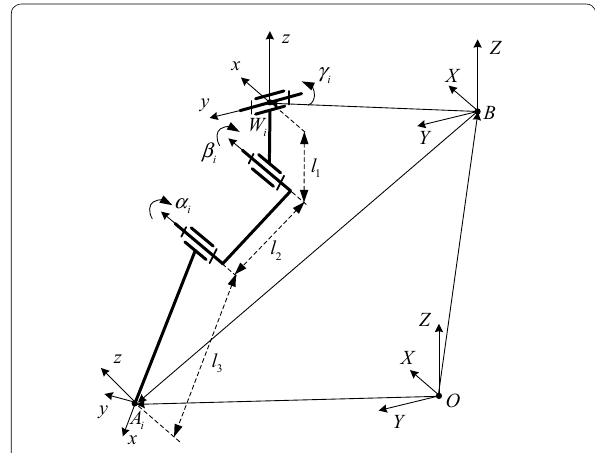
Figure 8 Mechanism of swing leg i